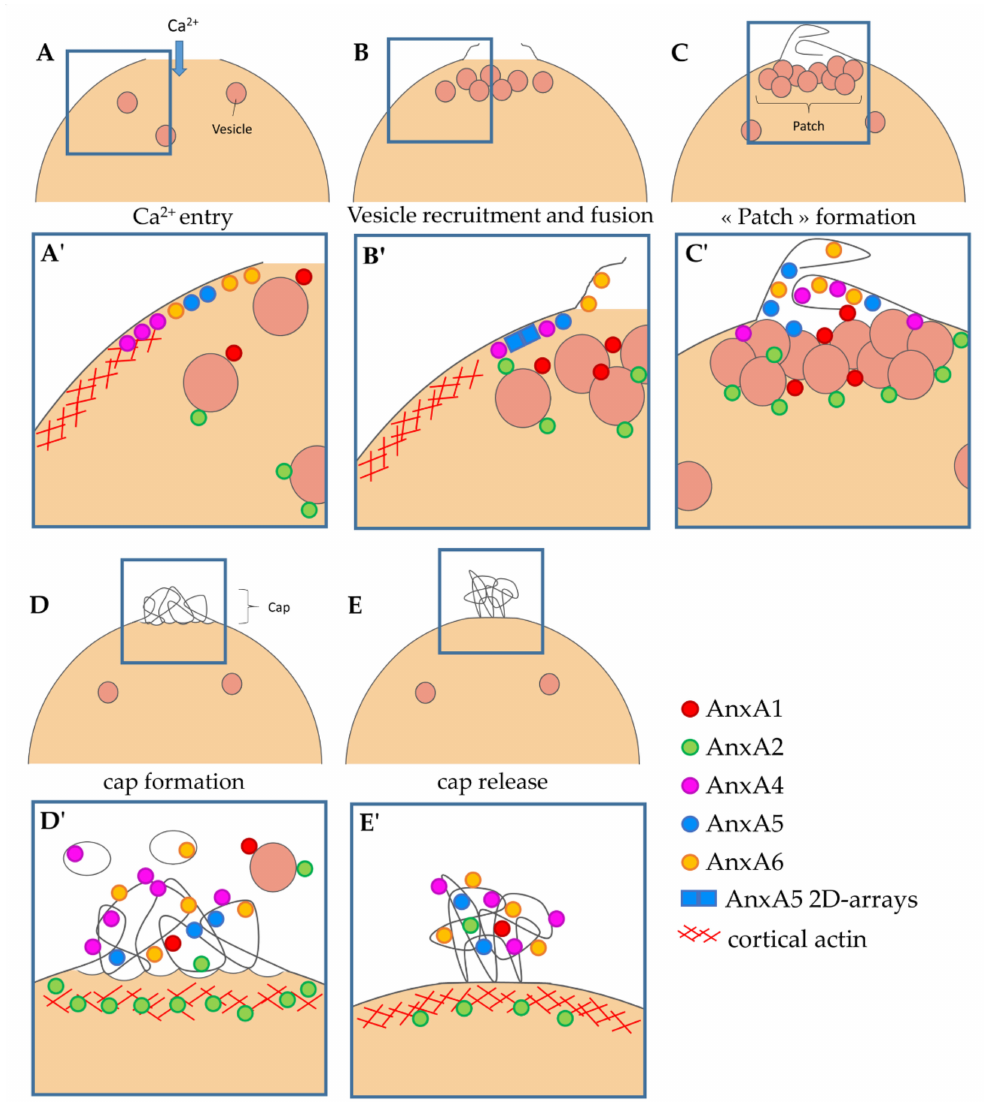
Figure 6. Model of cell membrane repair in human skeletal muscle cells. ( A , A’ ) Entry of Ca 2+ induces the recruitment of ANX to injured sarcolemma, notably ANXA5 [15], ANXA6 [17] and ANXA4. It induces also the recruitment of ANXA1/A2-bearing intracellular vesicles. ( B , B’ ) Membrane tension is reduced by depolymerization of actin and exocytosis of lysosomes [37]. Increase in sarcolemma surface leads to excess membrane at the disruption site, on which ANXA6 is associated [17]. ANXA5 forms 2D arrays that strengthen the sarcolemma and limit the expansion of the tear [15]. Intracellular vesicles are recruited to the disruption site. ( C , C’ ) Aggregation of intracellular vesicles forms the lipid patch that plugs the rupture. ANXA4 and ANXA6 induce folding of the extensions of sarcolemma in order to form a tight structure. ( D , D’ ) Accumulation of ANX leads to folding and curvature of membranes [38] and the formation of the cap subdomain [16,17]. ANXA2 may promote repolymer- ization of cortical actin [7]. At this time, some vestiges of the lipid patch (rich in ANXA1 and ANXA2) and sarcolemma fragments (rich in ANXA4 and ANXA6) are present in the extracellular milieu. ( E , E’ ) Integrity of sarcolemma is restored by membrane reconstitution and elimination of the cap subdomain by macrophages (not represented) [39]. Adapted from [17].